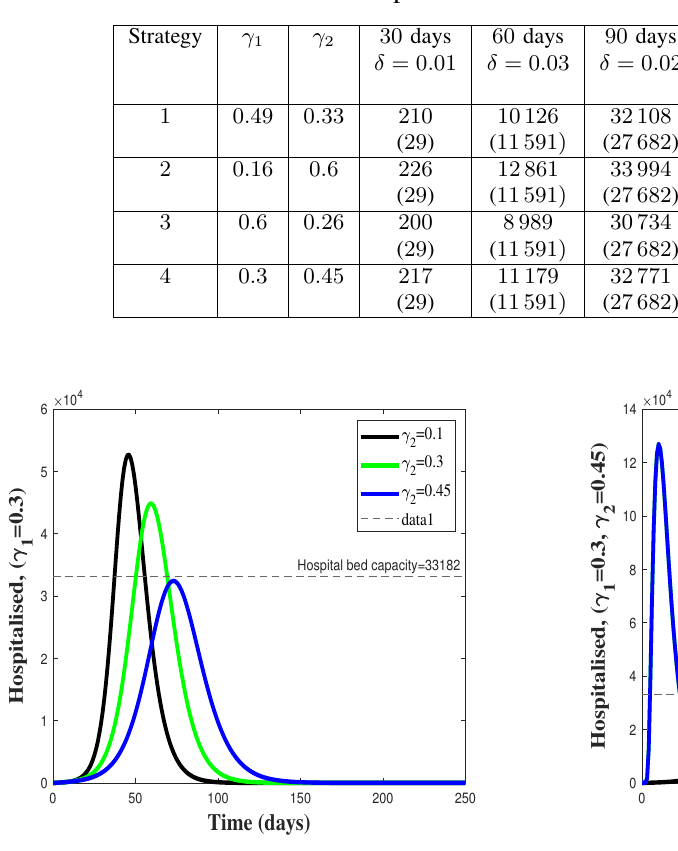
Fig. 10: Population level plots for hospitalized individuals for varying values of α